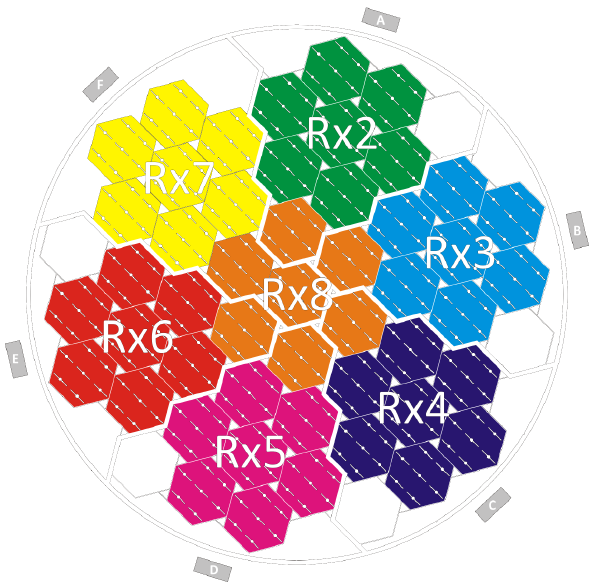
Fig. 11. The receiver configuration of MAARSY during the ECOMA sounding rocket campaign.